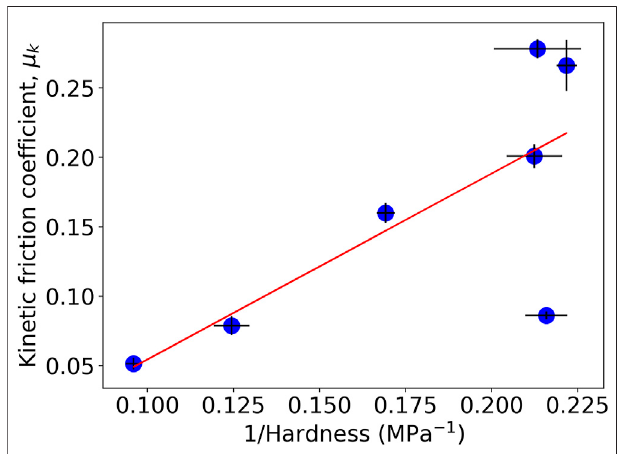
FIGURE4| Inversecorrelationbetweenthehardnessandkineticfriction coef fi cientforL(XG)coatingsinarangeofenvironmentalconditions.Bluedata points represent a storage and test RH of 10%; orange points represent an RH of 90%. Vertical error bars indicate the standard deviation in μ k , horizontal error bars indicate the propagated standard error in the mean hardness.